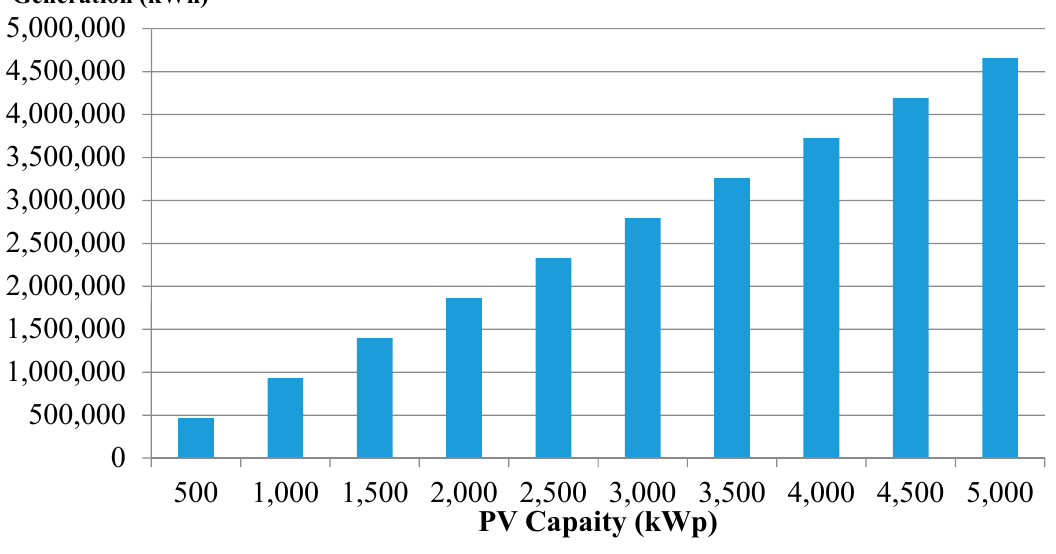
Figure 4. Annual PV real power generation (in kWh).